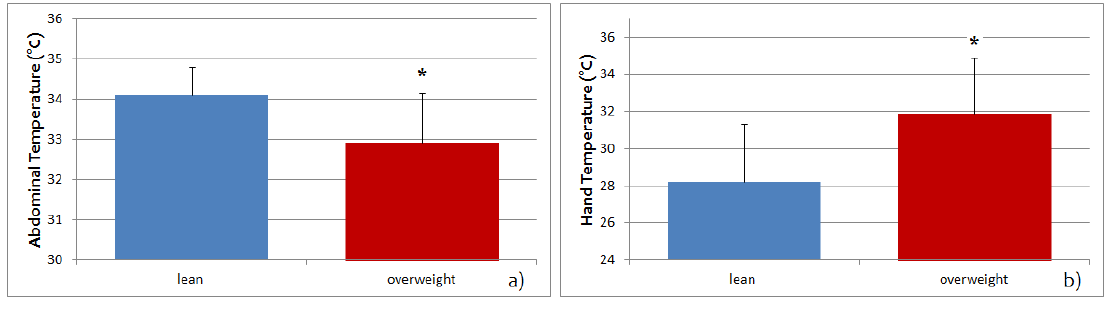
Figure 3. Abdominal ( a ) and hand ( b ) temperature at the baseline for lean and overweight groups. Statistically significant differences between the two groups are found both in abdominal and hand temperature, with the opposite trend.